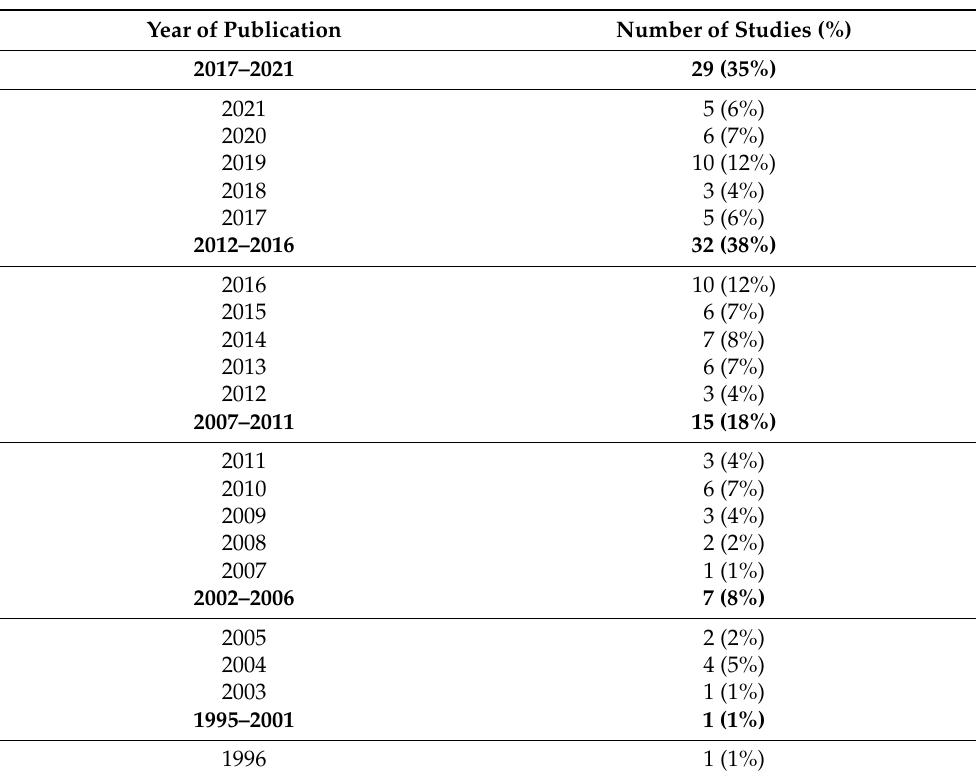
Table A1. Distribution of studies by year of